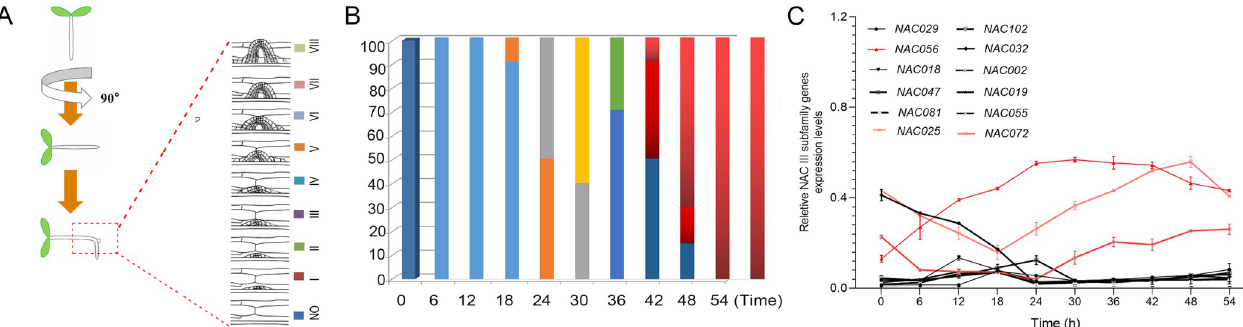
Fig 1. Transcriptomic analysis of subclass III NAC genes during lateral root (LR) initiation. B. After gravitropic stimulation to induce the synchronized initiation of lateral root primordium (LRP) at the surface of bending roots, LR primordium stages from I to VIII were assessed every 6 h between 0 and 54 h after gravitropic stimulation and are represented here as a percentage of the total number of observed LRPs at each time point. At least 90 LRPs were observed at each time point. C. Expression patterns of all subclass III NAC genes at each time point during LR initiation were measured every 6 h from 6 to 54 h post gravitropic induction (pgi). Bending roots of a population of 5-day-old seedlings were micro-dissected at each of ten time points, which were then used for RNA extraction (approximately 200 seedlings per time point for each of three independent replicates). Expression patterns of all subclass III NAC genes are shown. Each data point represents the mean ± SE (n =